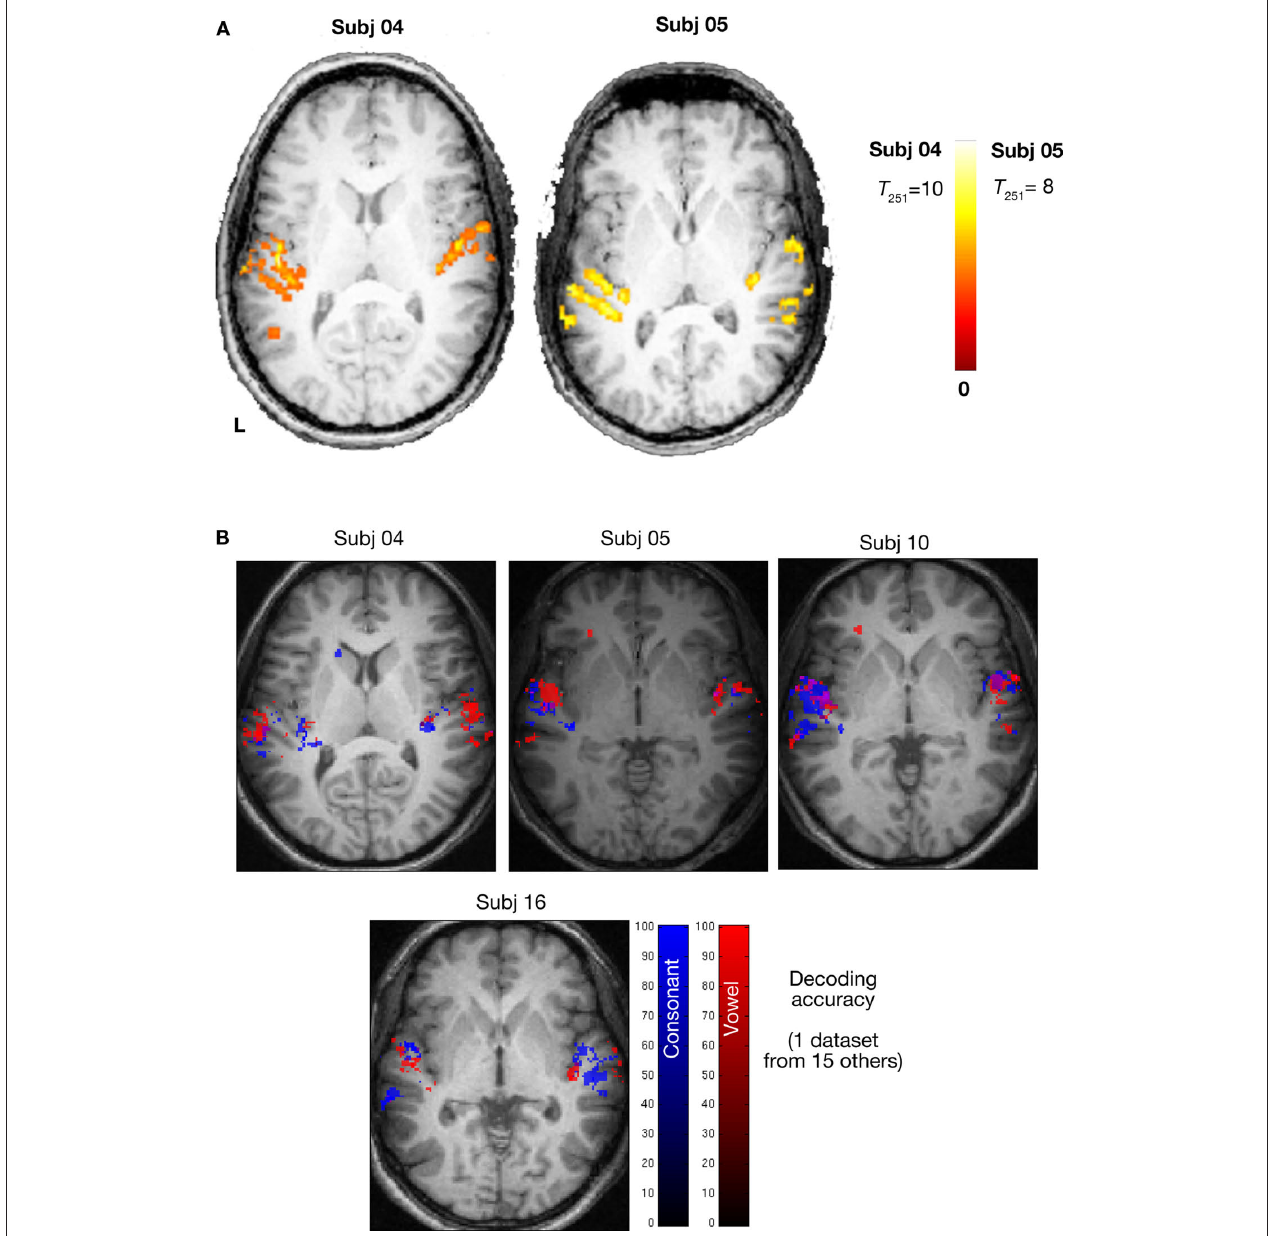
FIguRe A1 | (A) Exemplary single-subject activations in sound > silence contrast, thresholded at p < 0.001 at the voxel-level, using a Wavelet SPM analysis of individual, non-smoothed, native-space image time- series; displayed on individual T1-weighted structural images. (B) Examples for single-subject vowel (red) and stop (blue) classification